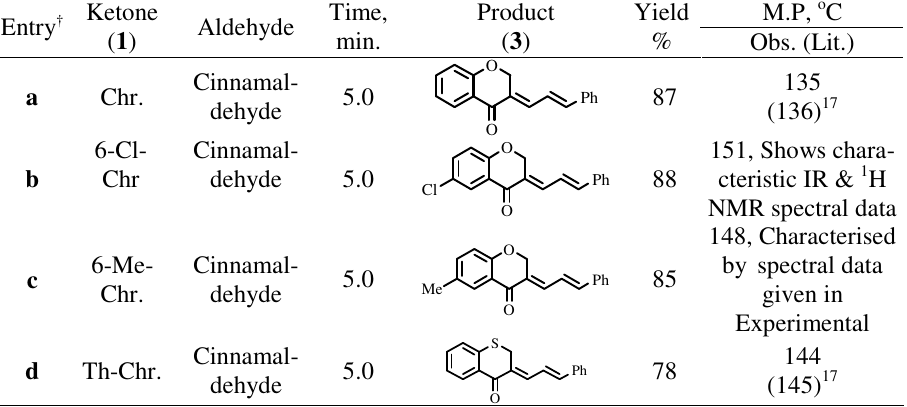
Table 2. Microwave assisted synthesis of E -3-cinnamylidenechroman-4-ones and E -3-